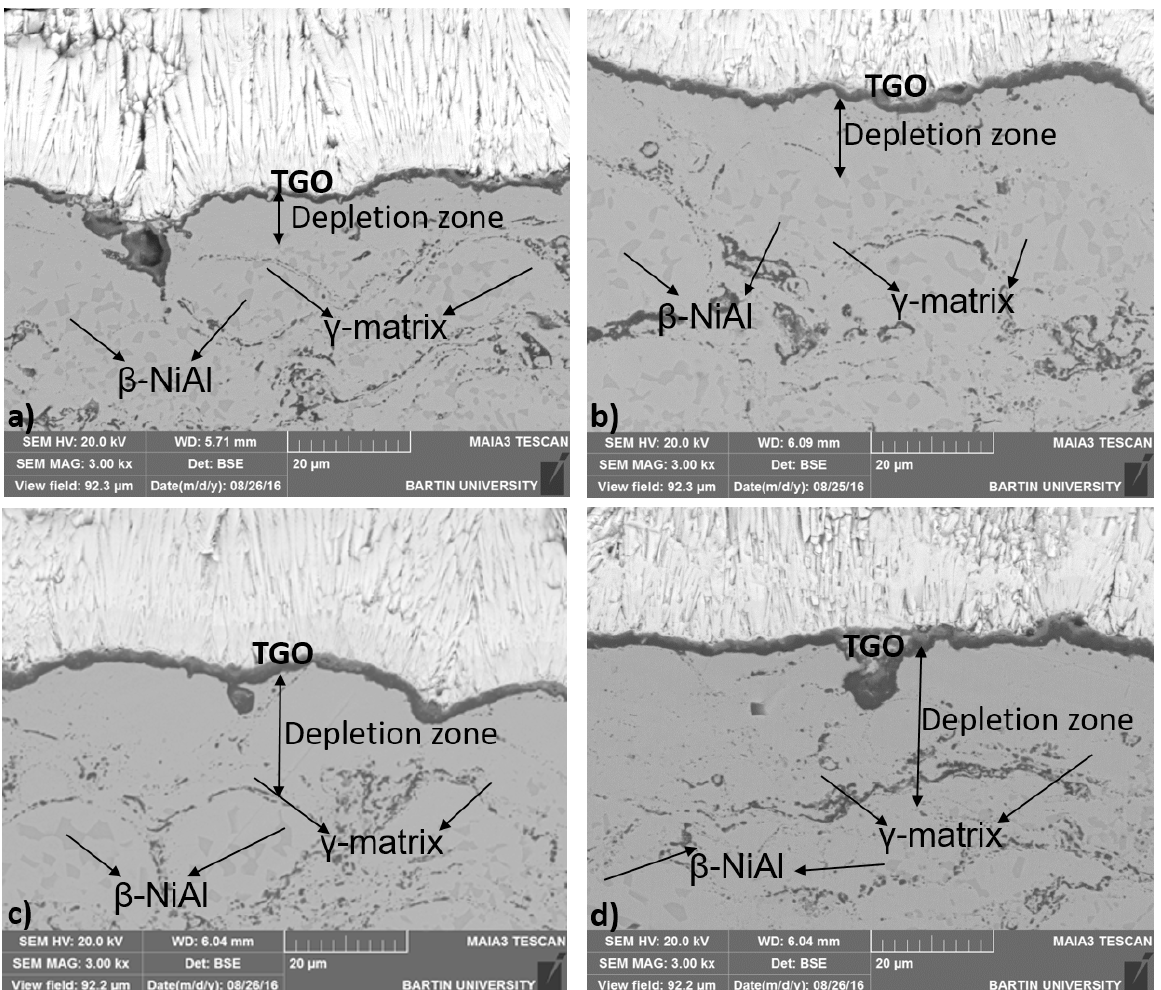
Figure 2 : Cross-sectional images of a) 8 h, b) 24 h, c) 50 h and d) 100 h oxidized TBCs at